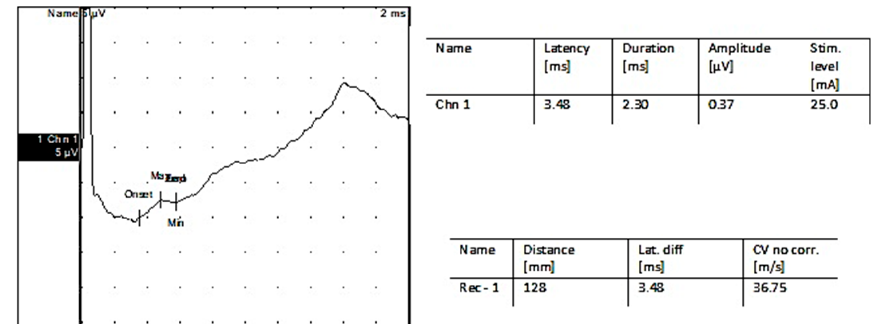
Figure 4. Sensory nerve conduction: Left superficial peroneal nerve.